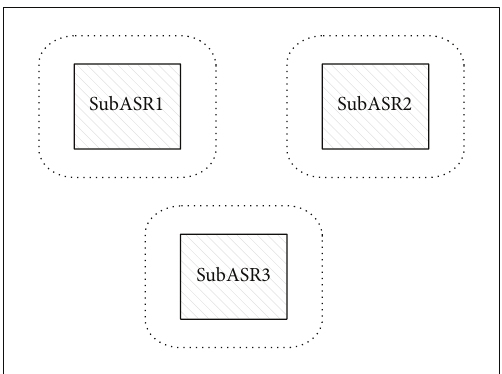
Figure 2: Principle of query algorithm at the LBS